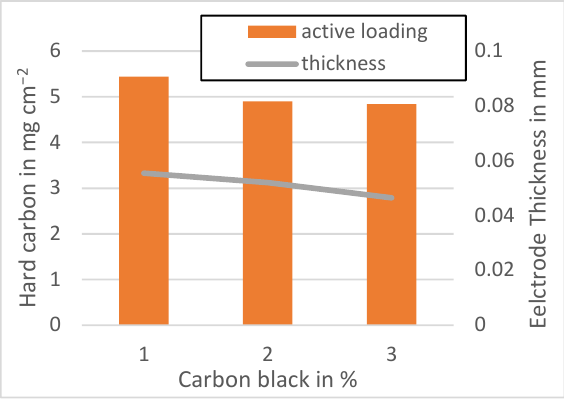
Figure A4. Active material loading of the Kuranode anodes mixed at 1500 rpm.